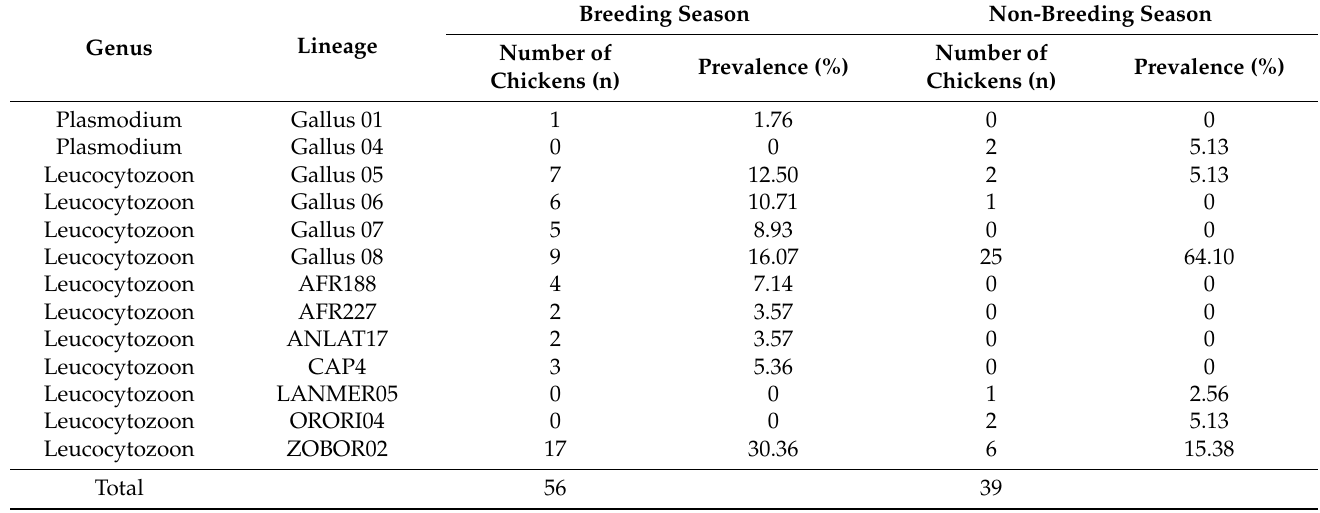
Table 1. Parasite lineage and prevalence in the breeding and non-breeding seasons.